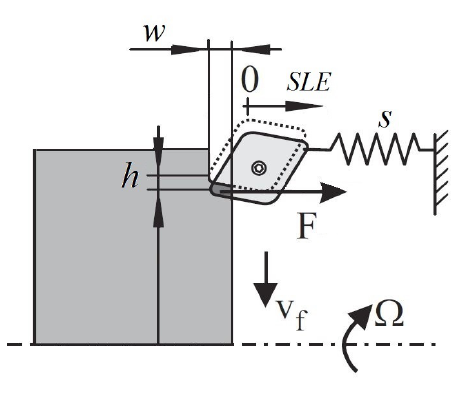
Figure 1. SDoF turning dynamical